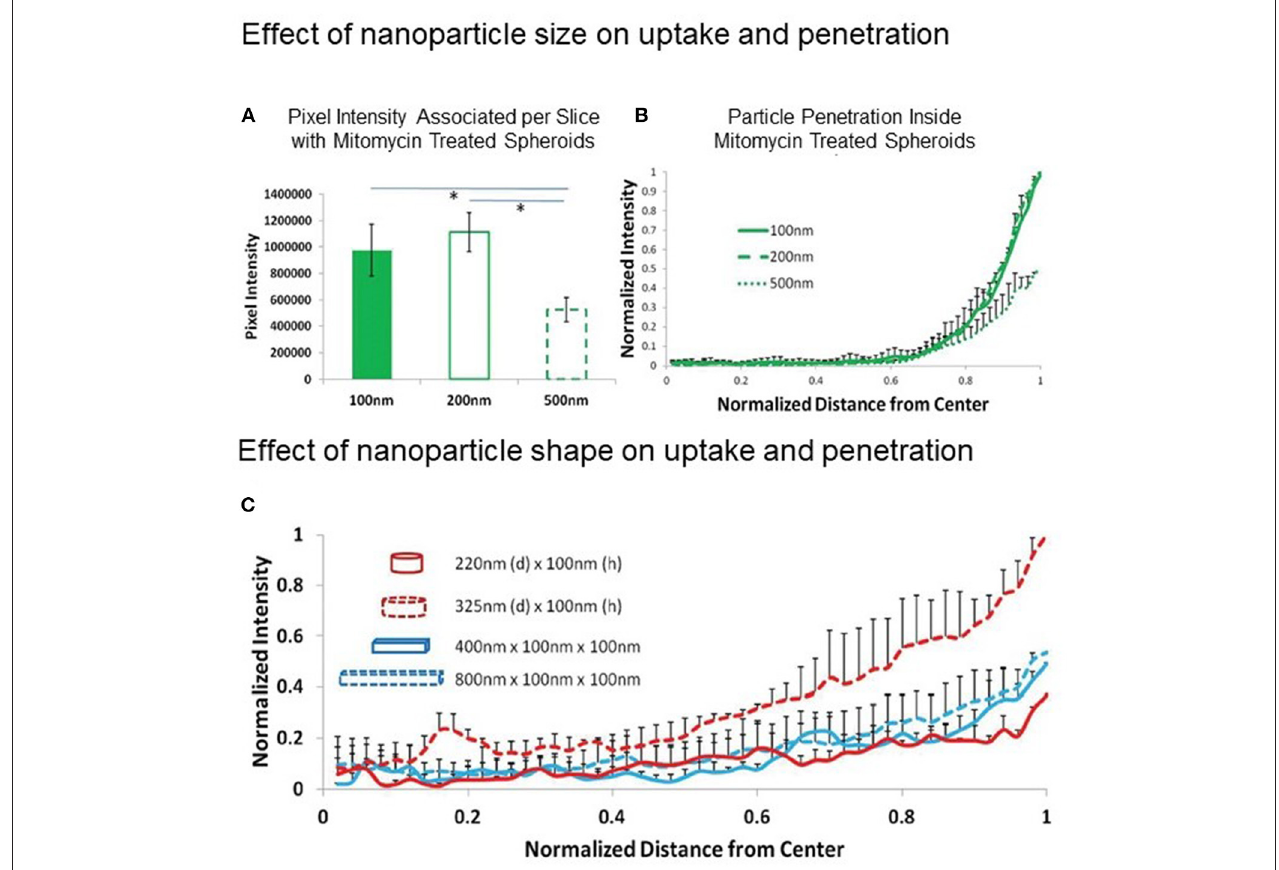
FIGURE 2 | Effect of NP size and shape on MCTS uptake and penetration. (A,B) Effect of NP size: uptake and penetration of spherical 100, 200, and 500nm polystyrene particles in Mitomycin C-treated HEK 293 spheroids. (A) Graph showing comparison of normalized pixel intensity associated with spheroid per slice with different diameter polystyrene beads and (B) Normalized radial intensity distribution of polystyrene beads as a function of distance from the center of the spheroid. (C) Effect of NP shape: normalized radial intensity distribution of shape-specific nanoparticles as a function of distance from the center of the spheroid. Only positive error bars are shown, to allow proper visualization of data. Reproduced with permission from Agarwal et al. (43) (John Wiley and Sons License, license number 5306710208408).